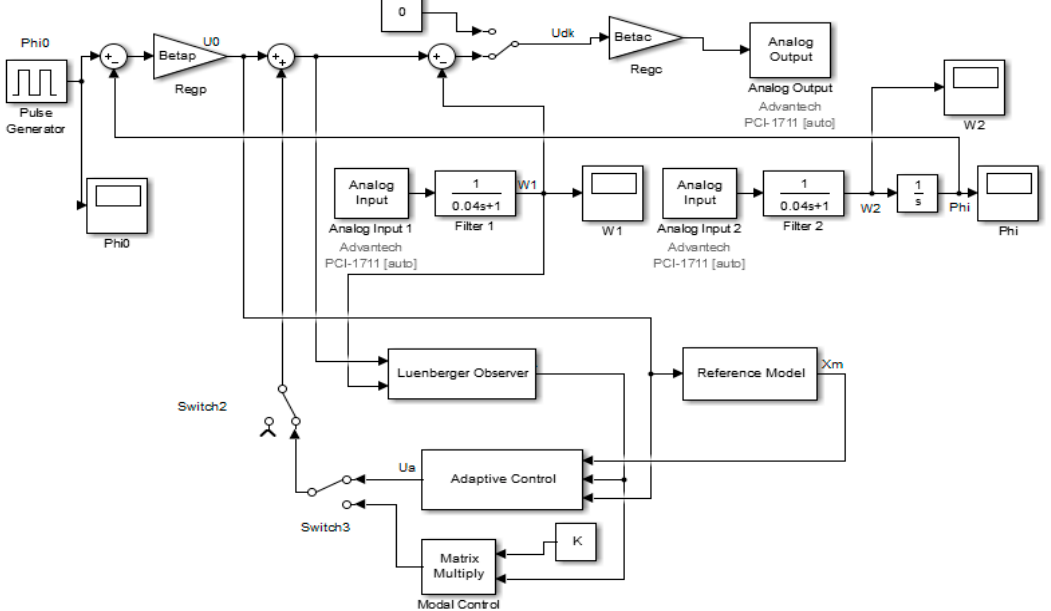
Figure 5. The structure of the real-time controller.